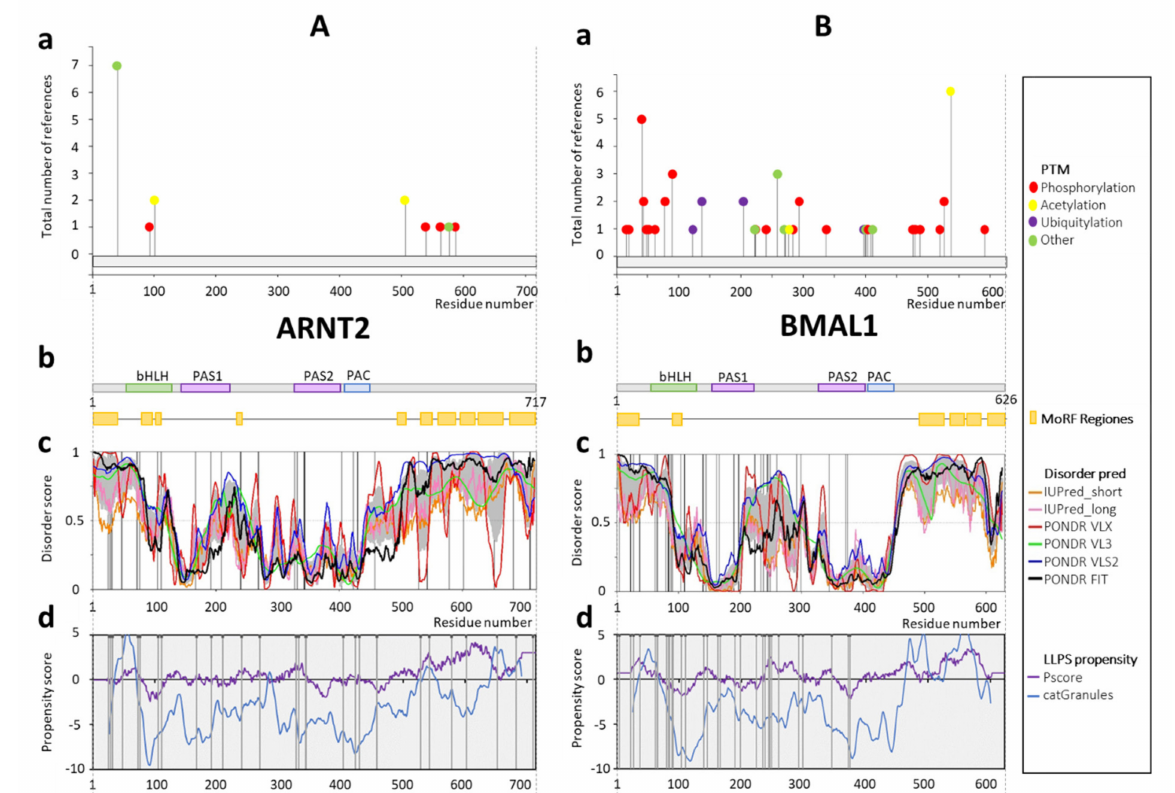
Figure 5. Schematic presentation of results for ( A ) ARNT2 (Q9HBZ2) and ( B ) BMAL1 (O00327) analysis. ( a ) Post-translation modifications based on PhosphoSitePlus server [99]; ( b ) the domain structure of protein, green indicates the bHLH domain (63–116aa ARNT2;72–125aa BMAL1); purple represents PAS domains (134–209aa PAS1, 323–393aa PAS2, ARNT2; 143–215aa PAS1, 326–396aa PAS2 BMAL1), whereas blue indicates PAC (398–441aa PAC ARNT2; 401–444aa PAC BMAL1). Predicted MoRFs [100] are indicated as orange rectangles, ( c ) D 2 P 2 database disorder regions predictions based on the protein amino acids sequence (find the legend in the plot for description). Grey shadow presents the averaged disorder profile, and a score over 0.5 indicates a high probability of disorder. Positions of disease-linked mutations are marked as black vertical lines (listed in HuVarBase database [101], Supplementary Materials), ( d ) LLPS propensity predictions based on catGranules (blue line) [102] and PScore (purple line) [103] servers; positions of disease-linked mutations are marked as black vertical lines (listed in HuVarBase database [101], Supplementary